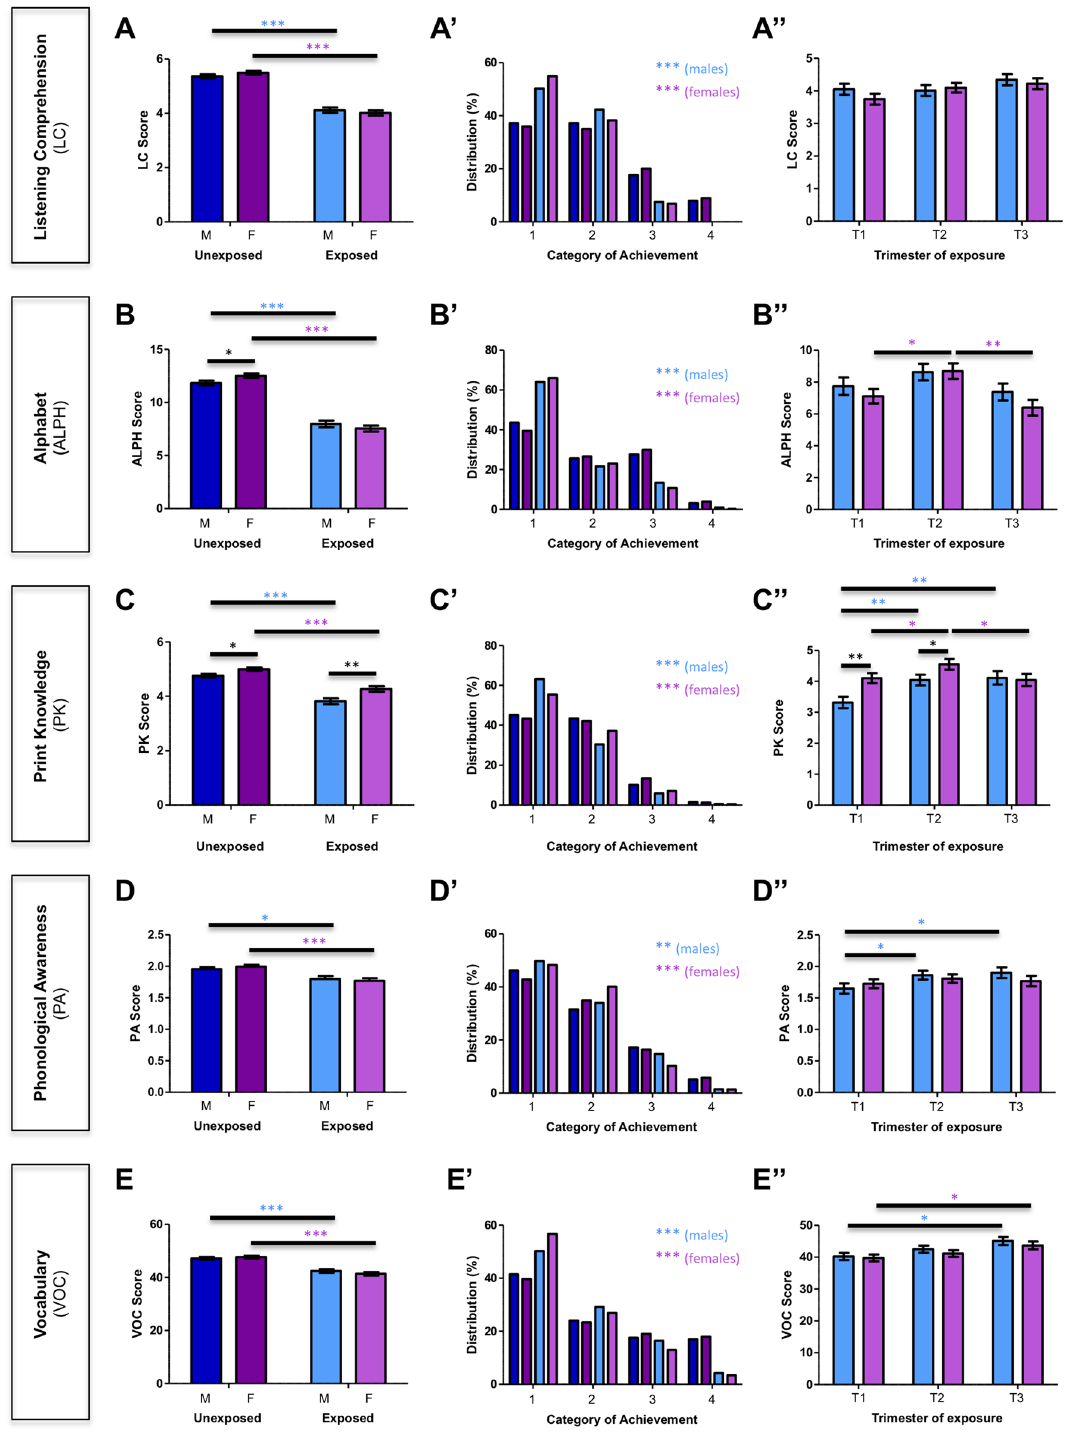
Figure 2. Sex differences of prenatal exposure and timing of exposure to 27F earthquake on pre-reading skills. ( A – E ) Scores obtained by unexposed and exposed children by sex. M male, F female. *p < 0.05; **p < 0.01; ***p < 0.001 (Mann–Whitney U test). ( A ′ – E ′ ) Distribution (%) of females and males per category of achievement. Categories considered were 1: “delayed”; 2: “normal”; 3: “very good”; 4: “outstanding”. **p < 0.01; ***p < 0.001 exposed vs. unexposed (males and females) (Fisher’s exact test). ( A ″ – E ″ ) Scores obtained by exposed females and males according to the gestational trimester of exposure. T1: first trimester; T2: second trimester; T3: third trimester. *p < 0.05; **p < 0.01; ***p < 0.001 (males vs. females in each trimester: Mann– Whitney U test; males and females comparing T1, T2 and T3: Dunn’s test—multiple pairwise